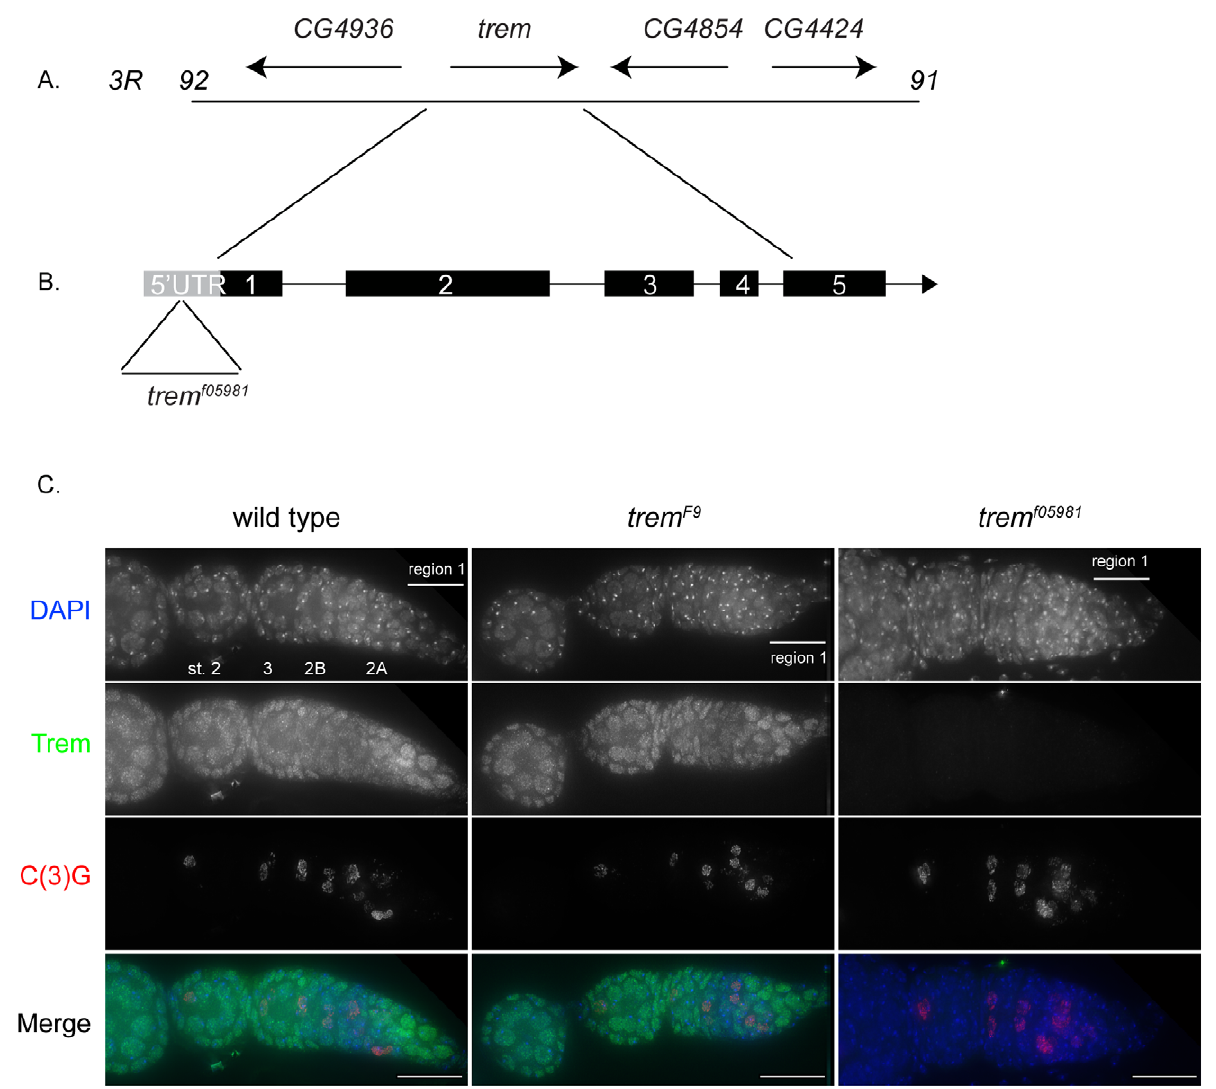
Figure 1. trem localization and expression. (A). Schematic diagram of the trem gene and its location on 3R . trem is found in a cluster of 4 genes all of which are predicted to encode C2H2-type zinc finger proteins. (B) Black boxes depict the 5 exons in the trem gene. A piggyBac -element insertion used in this study, PBac[WH]trem f05981 , is located in the 5 9 UTR 55 bp upstream of the start codon of trem . An Upstream Activation Sequence (UAS) within the PBac{WH}- element is oriented in the same direction as the trem gene. The UAS can be used to drive expression of trem . (C) Expression of trem in the germline of wild type, trem F9 and trem f05981 females. Maximum intensity projection of deconvolved Z-series through whole mount germarium stained with DAPI and antibodies to Trem and C(3)G, and the merge. Location of the developmental stages within the germarium is shown in the wild-type image. Each ovary is made up of approximately 16 ovarioles that are arranged according to developmental age [50]. In region 1, the cystoblast initiates 4 rounds of pre-meiotic divisions with incomplete cytokinesis to form a 16-cell interconnected cyst. In region 2A, meiotic prophase begins, full length SC is formed (here identified by an antibody to the major transverse filament protein C(3)G) and recombination is initiated. As the cysts move posterior, pachytene continues in region 2B (recognized by pancake shaped cysts) until it reaches region 3 where the disappearance of c -His2Av foci indicate the repair of a DSB event. The cyst then leaves the germarium and enters the vitellarium. No observable difference could be detected in either trem expression or localization between wild-type and trem F9 germarium. Trem was not detected in trem f05981 ovaries, and therefore we consider it to be a null allele. In addition, no defect in SC formation (using an antibody to C(3)G) was detected in either trem mutant compared to wild type. Scale bar, 15 m